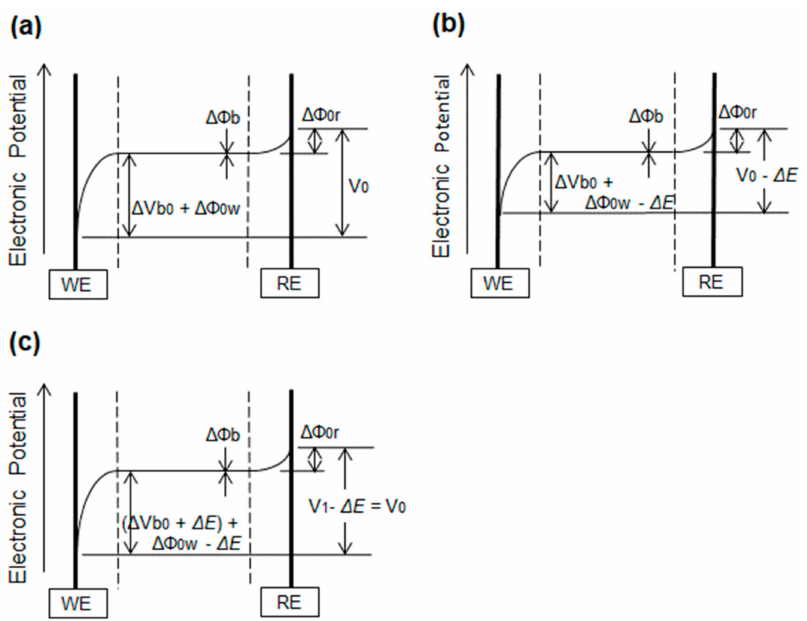
Figure 3. ( a ) Electric potential between the WE and reference electrode (RE) prehybridization for a measurement current ( im ) at an external bias of V 0 . ( b ) After hybridization, the electronic potential between the RE and WE decreases by ∆ E due to the negative charge on the hybridized oligonucleotide, ∆ Q. There will be a reduction in the current if the external bias is identical to V 0 . ( c ) To retrieve the identical current ( im ), the external bias V 1 must be increased by ∆ E : ( V 1 = V 0 + ∆ E)